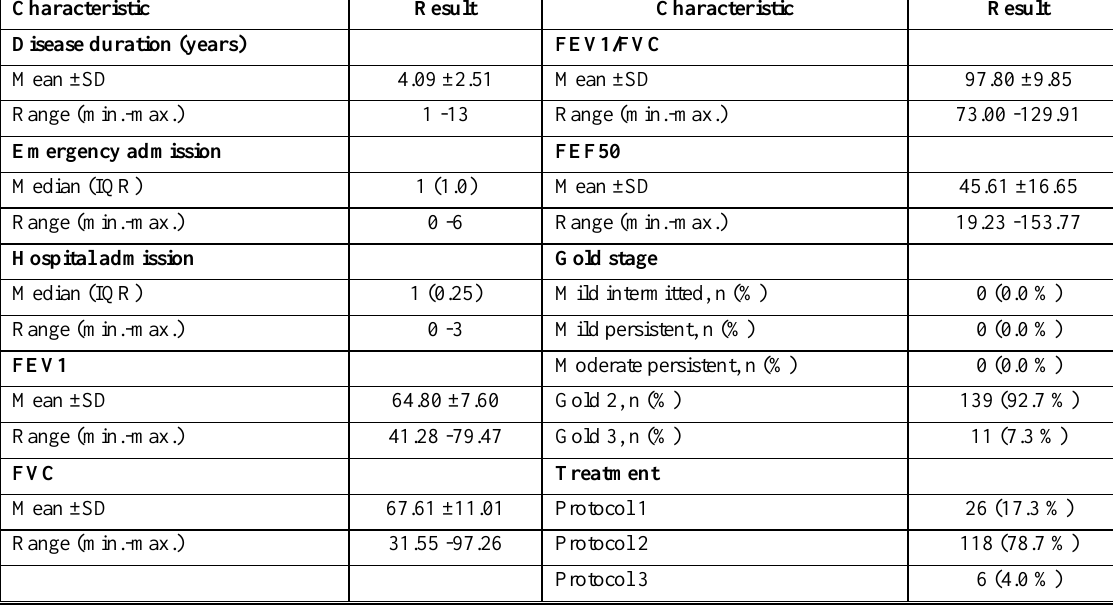
Table 2. Disease characteristics of COPD patients enrolled in the current study Characteristic Result